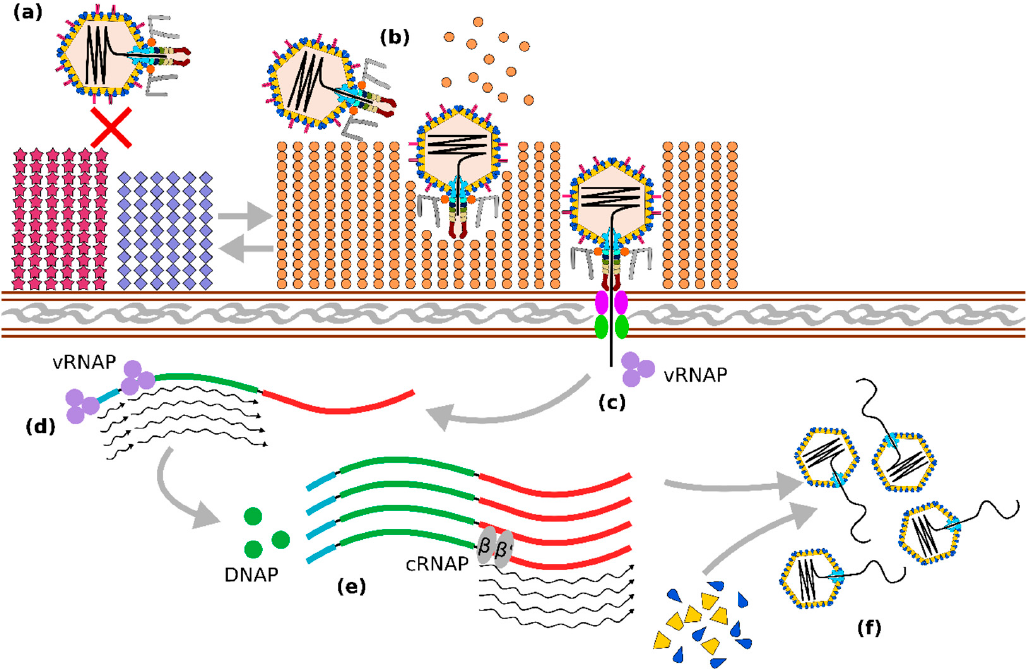
Figure 3. Some known elements of the Crassvirales life cycle. Adsorption and infection of Bacteroides cells by crAss-like phages are regulated by the expression of alternating phase-variable capsular polysaccharide (CPS) types. Expression of non-permissive CPS prevents phage infection ( a ). while switching to permissive CPS allows phage attachment, hydrolysis of CPS by tail-associated depoly- merase enzymes, and ejection of phage contents ( b ). Phage DNA is co-injected with cargo proteins, among which are virion RNA polymerase (vRNAP) subunits responsible for transcription of early (regulatory) and middle (DNA replication) genes ( d ). Formation of DNA polymerase (DNAP) as well as other enzymes, allows for DNA replication through an unknown mechanism, followed by expression of the late genes (large terminase, structural proteins, virion cargo proteins), carried out by the cellular bacterial RNA polymerase complex (cRNAP), ( e ). This results in the formation of new virions and the packaging of phage DNA ( f ).